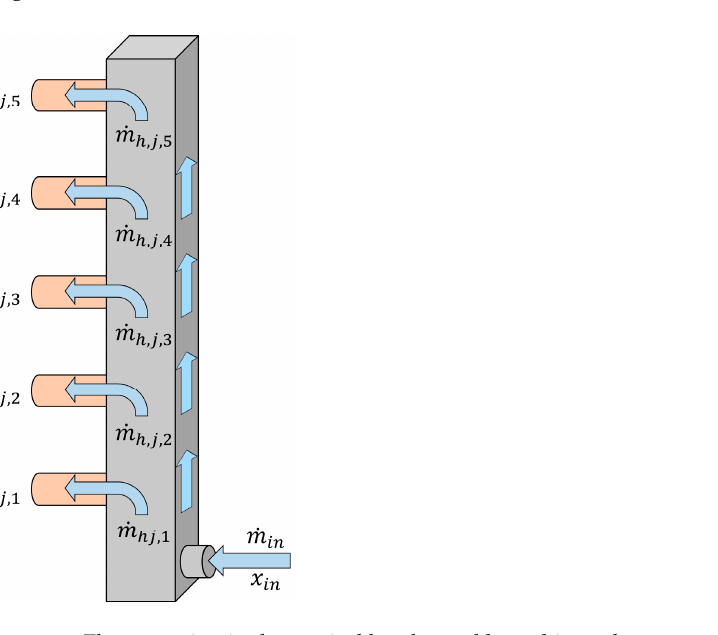
Figure 10. Flow notation in the vertical header and branching tubes.